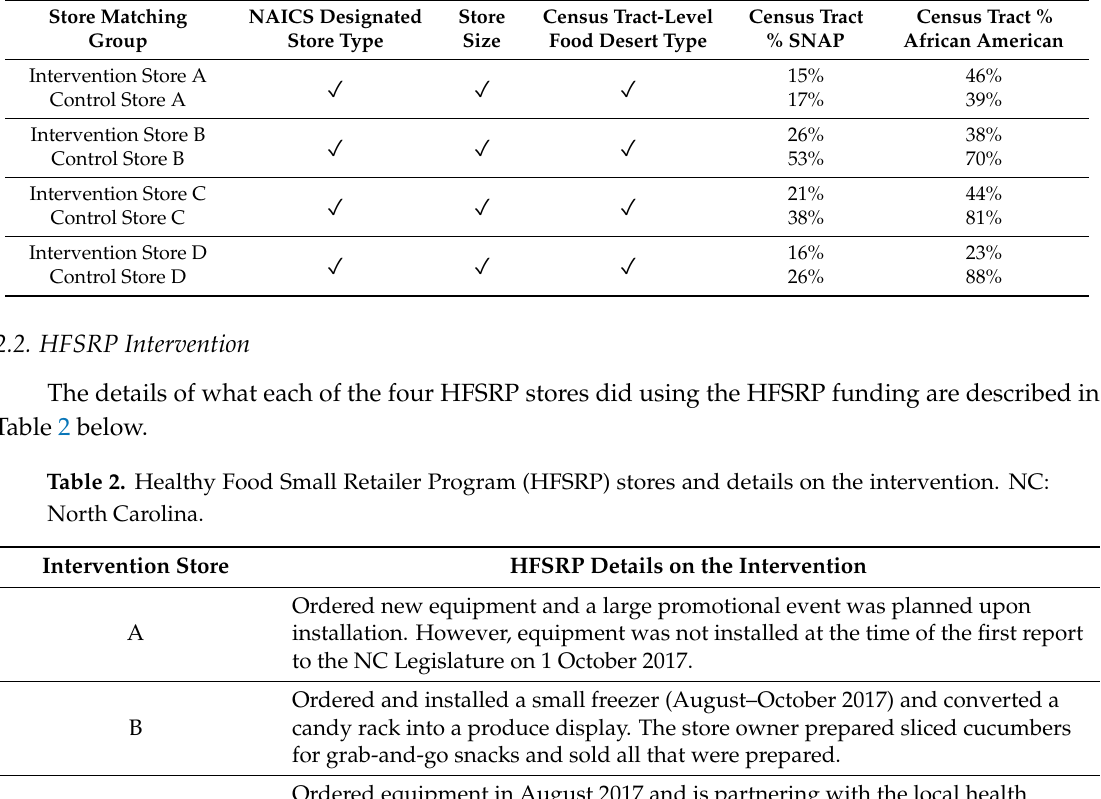
Table 1. Store matching variables for each matched pair of stores included. SNAP: Supplemental Nutrition Assistance Program; NAICS: North American Industry Code Standards.